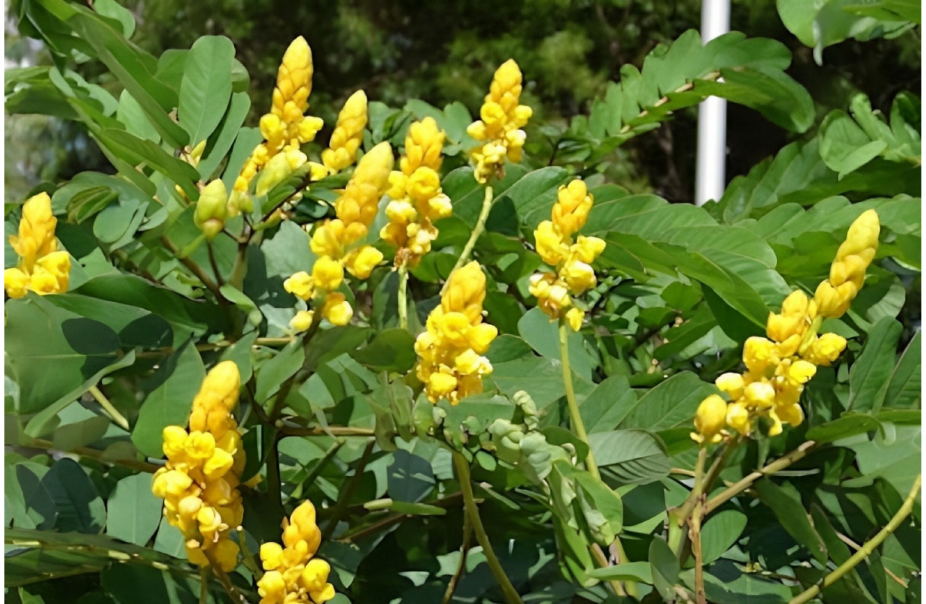
Figure 1. Cassia alata plant. The figure is adapted from Chew et al. [6], under the Creative Commons Attribution License.